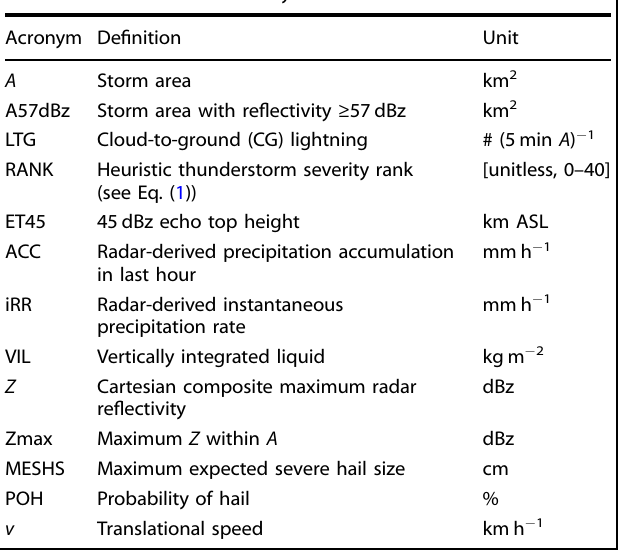
Table 2. Thunderstorm intensity